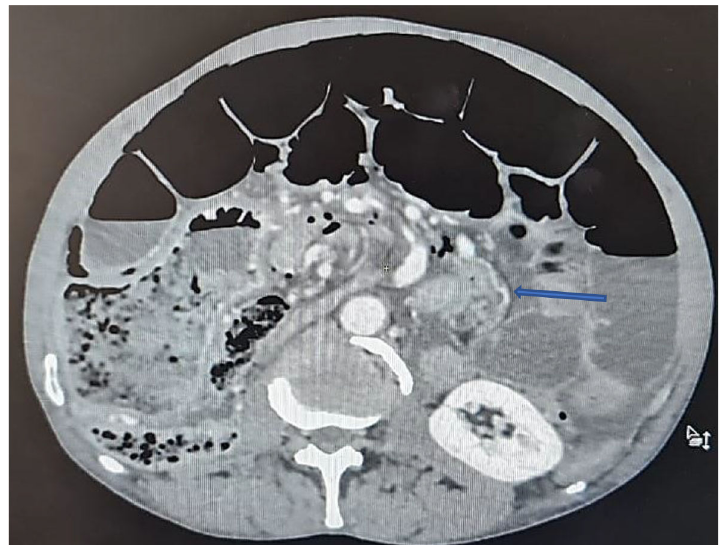
Figure 2. Ileal volvulus: dilated bowel segments associated with whirl sign.